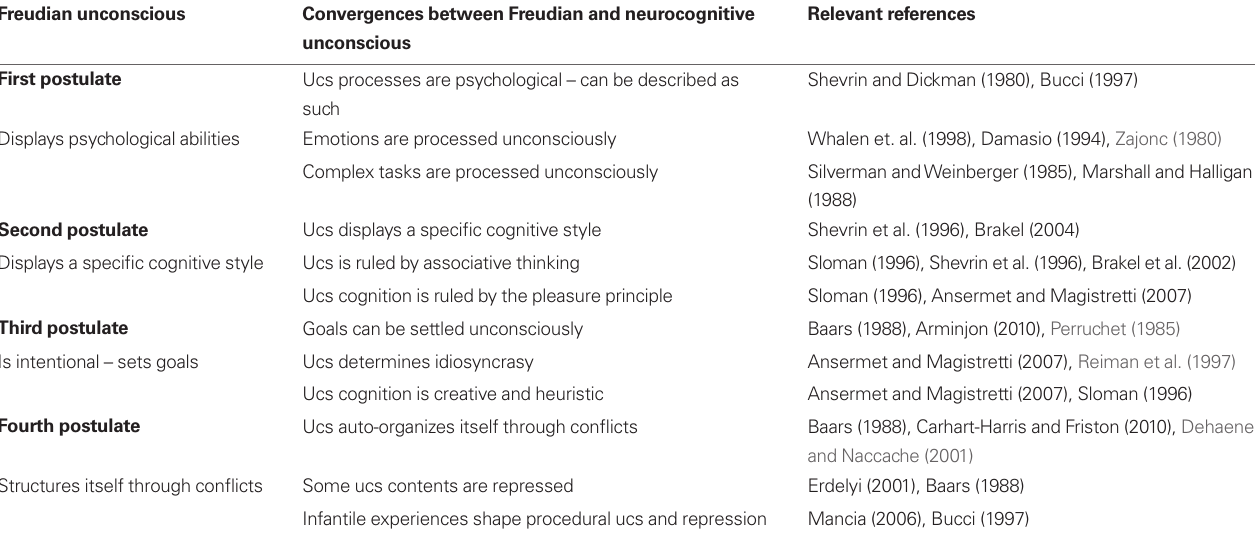
Table 1 | Labels attached to unconscious (ucs) in the neurocognitive literature, aligned on the four postulates of Freudian unconscious. Freudian